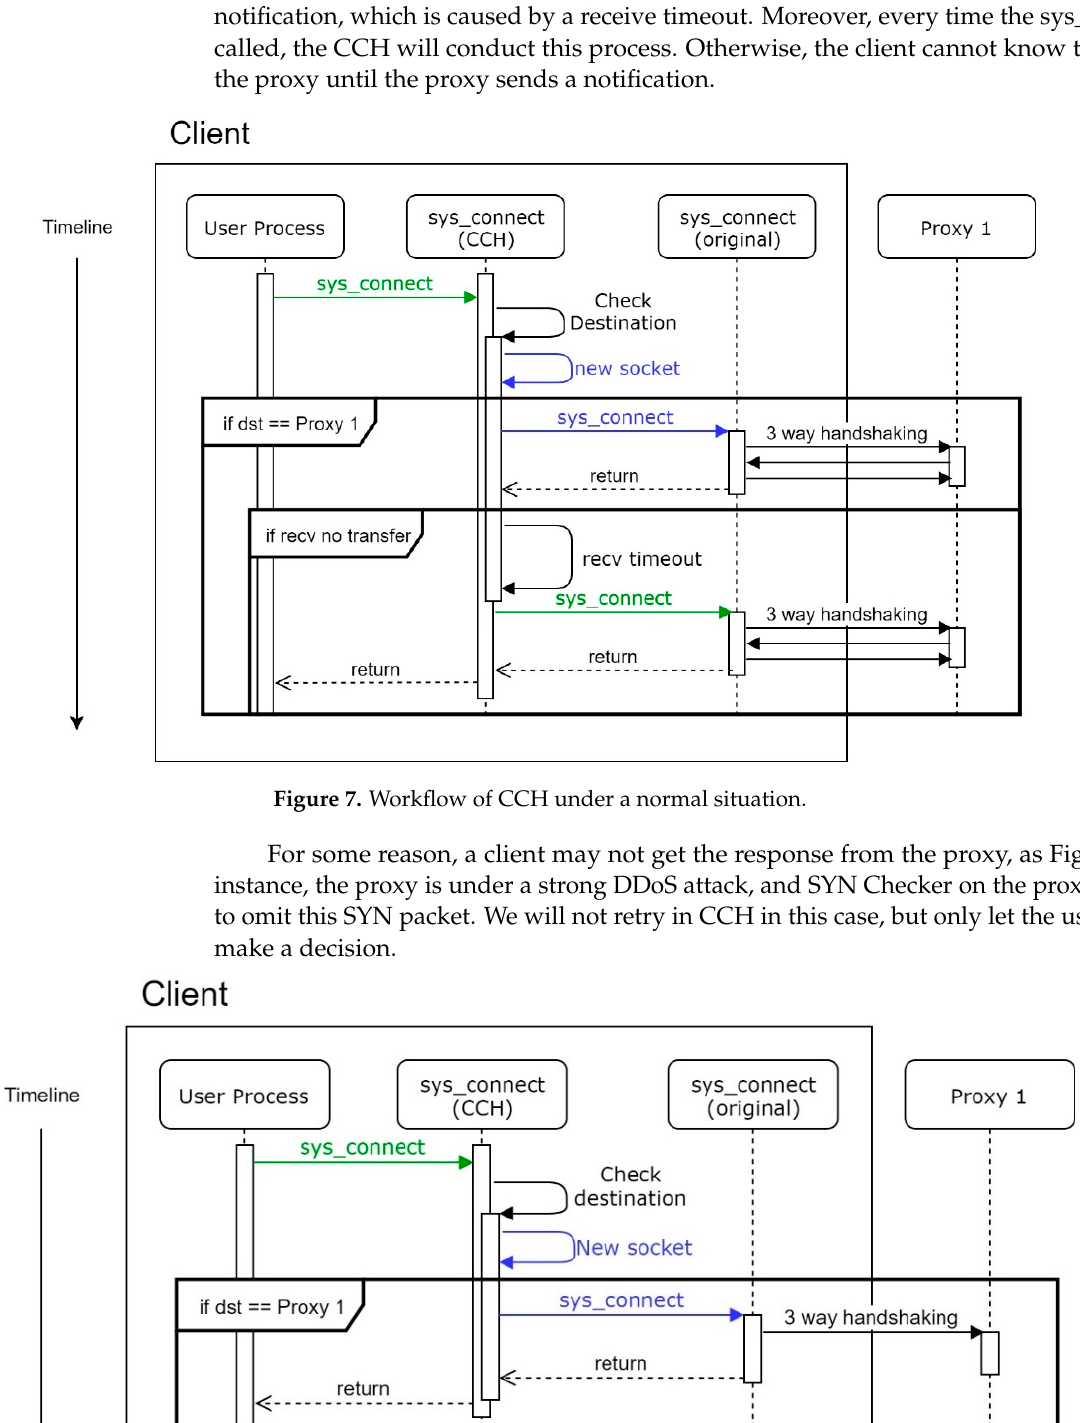
Figure 6. Workflow of Client Connection Handler (CCH).